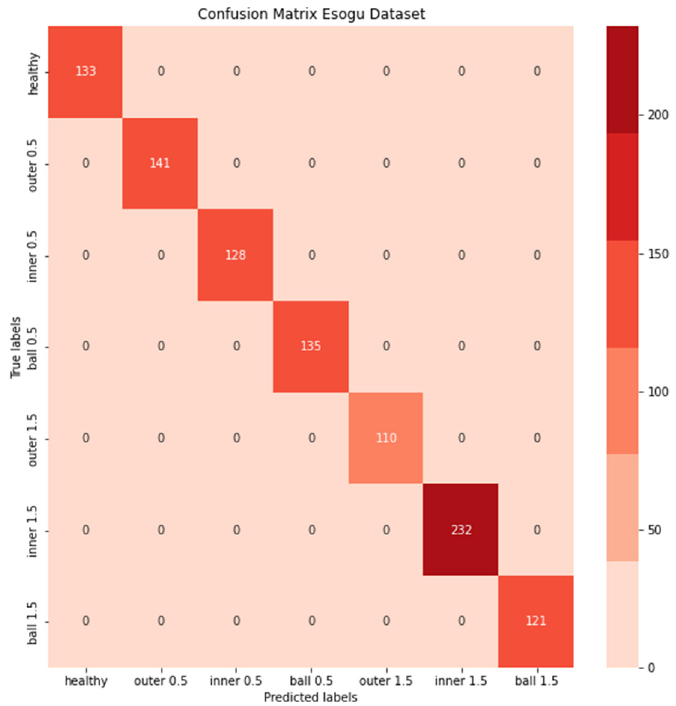
Figure 8. ESOGU dataset for seven-class confusion matrix.